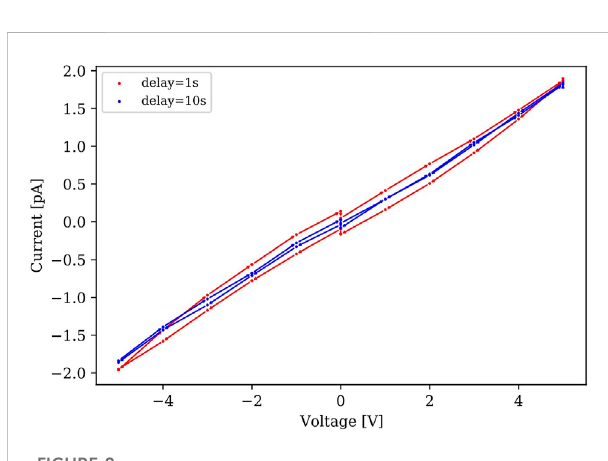
FIGURE 8 Current-voltage (I – V) hysteresis curves of a Ag/Cs 3 Bi 2 Br 9 /Ag device at room temperature.